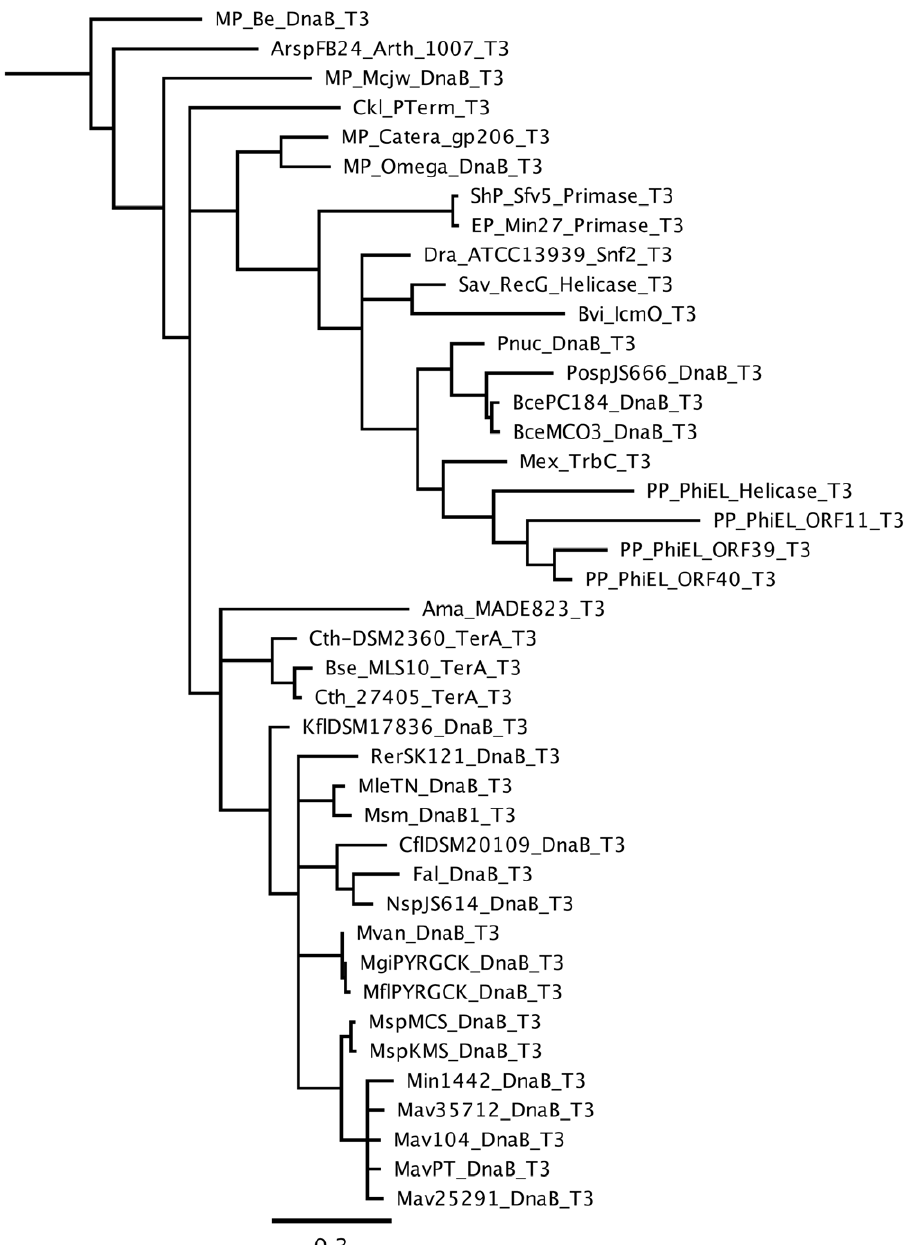
Figure 3. Class 3 inteins are monophyletic. A phylogenetic tree of Class 3 inteins based on conserved intein motifs was generated using MrBayes [15] in the Geneious software package. The scale bar represents 0.3 substitutions per site. A larger phylogenetic analysis previously excluded all non-Class 3 inteins examined from this clade [11]. Except for the Arsp-FB-24 Arth_1007 intein, intein names are defined in the InBase database (http://www.neb.com/neb/inteins.html) [6] with the additional T3 suffix, which indicates that these are Class 3